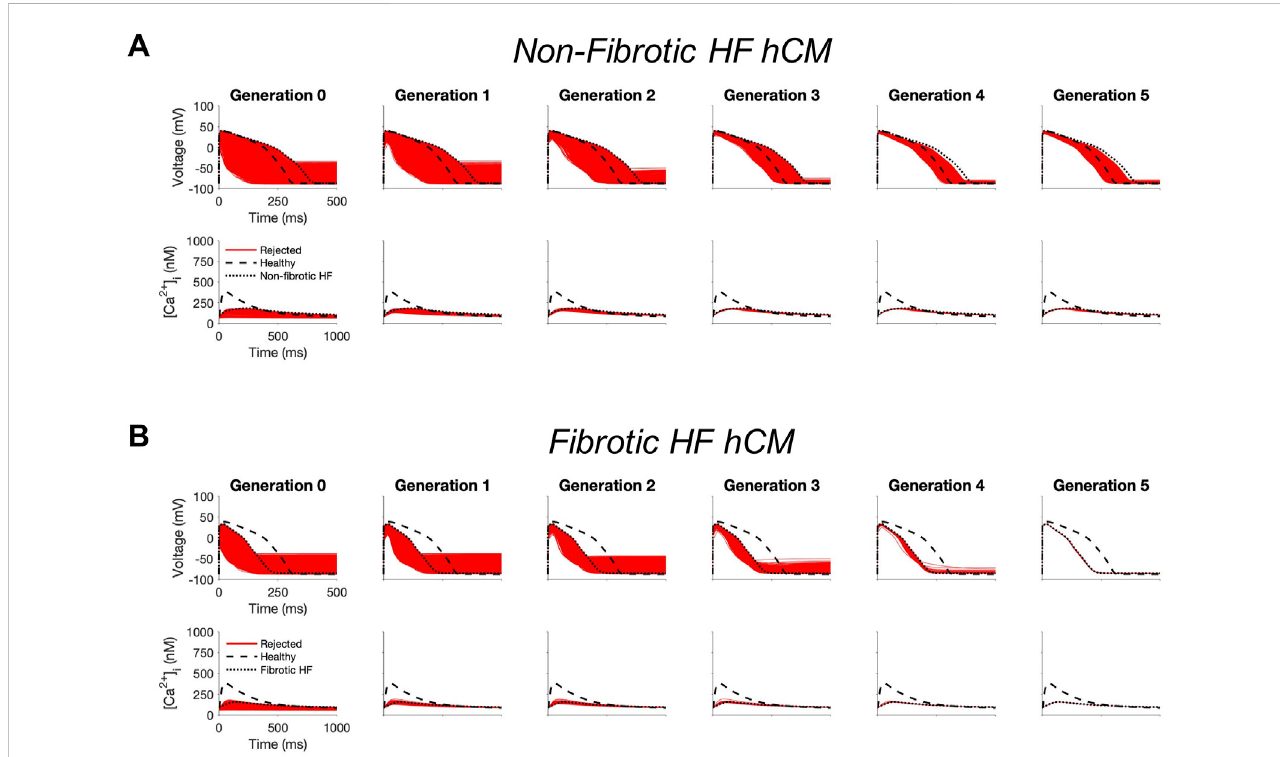
FIGURE 1 Genetic algorithm-based approach to identify custom cells expressing non-excitable cell channels are unable to restore failing cardiomyocyte phenotype. Initial populations of 2500 custom cell models were generated for heterocellular coupling with non- fi brotic (A) and fi brotic (B) human heart failure (HF) cardiomyocytes with pseudo-random perturbations of non-excitable cell ion channel maximal conductivities, gap junction conductances, and number of coupled cells. Custom cell populations underwent 5 generations of genetic algorithm evolution. Custom cells were accepted if root mean squareerrorwaslessthan50%relativetountreatedHFcardiomyocytesforbothactionpotentialandcalciumtransientwaveforms;inthissetofsimulations,all models were outside this range and were therefore rejected (red). Waveforms for healthy human cardiomyocytes (hCMs) and untreated HF cardiomyocytes are indicated by dashed and dotted lines,